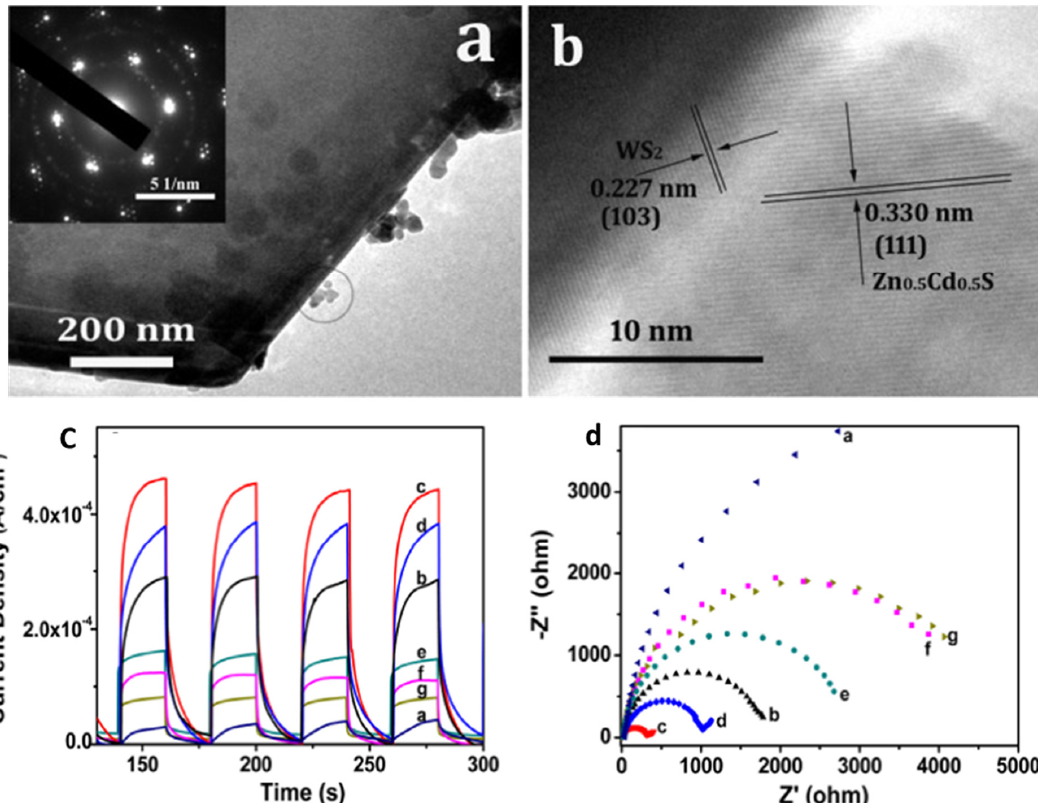
Figure 18. ( a ) TEM (SAED pattern) and ( b ) HR ‐ TEM image of the as ‐ prepared heterostructure Zn 0.5 Cd 0.5 S (41%). ( c ) photocurrent responses of WS 2 (a), Zn 0.5 Cd 0.5 S (33%) ‐ WS 2 (b), Zn 0.5 Cd 0.5 S (41%) ‐ WS 2 (c), Zn 0.5 Cd 0.5 S (47%) ‐ WS 2 (d), Zn 0.5 Cd 0.5 S (56%) ‐ WS 2 (e), Zn 0.5 Cd 0.5 S (63%) ‐ WS 2 (f), and Zn 0.5 Cd 0.5 S (g). ( d ) EIS Nyquist plots of the as ‐ prepared heterostructures. Reproduced with permission. [153] Copyright 2017, Elsevier.